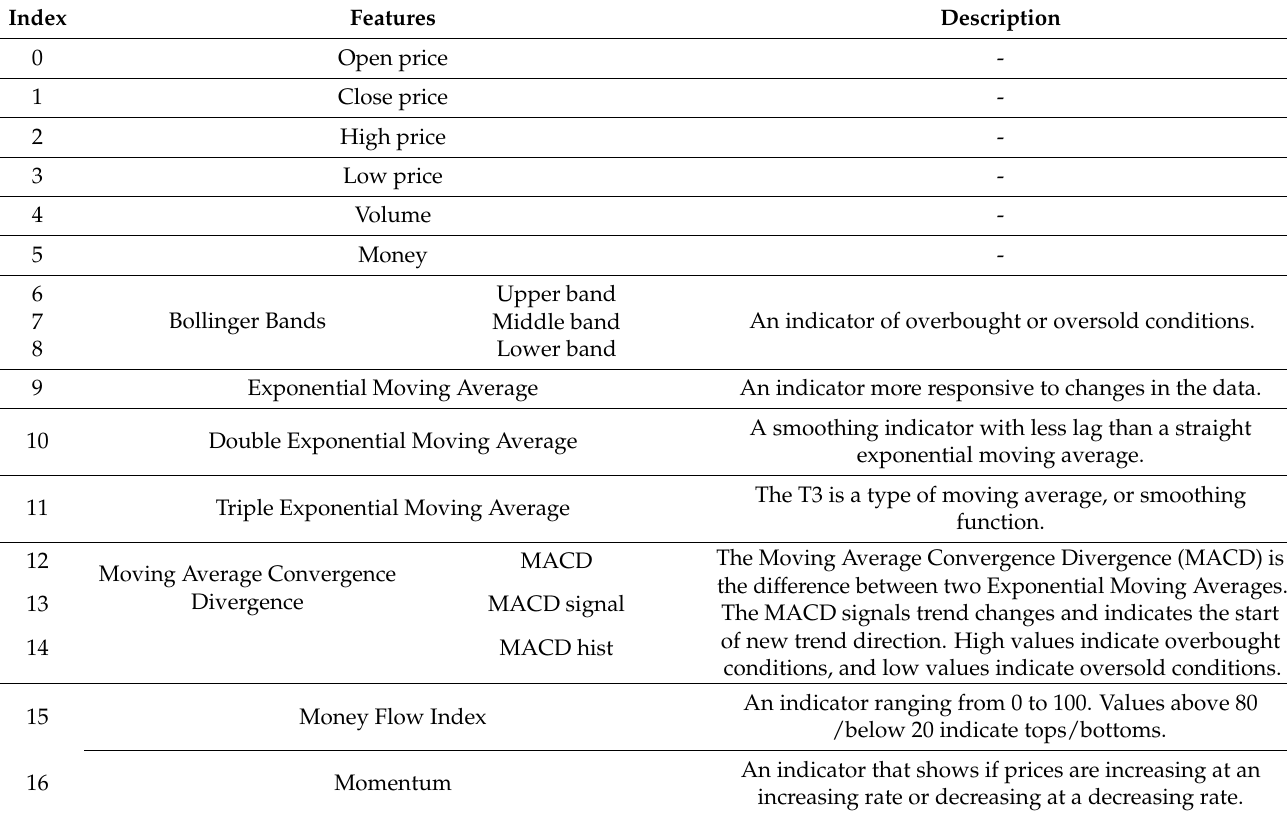
Table A1. Stock prices and technical indicators included as input